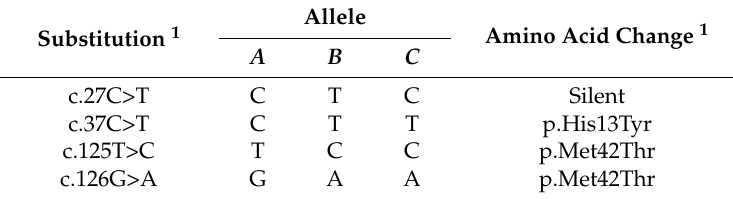
Table 2. Nucleotide substitution and alleles of the caprine KAP20-2 gene.